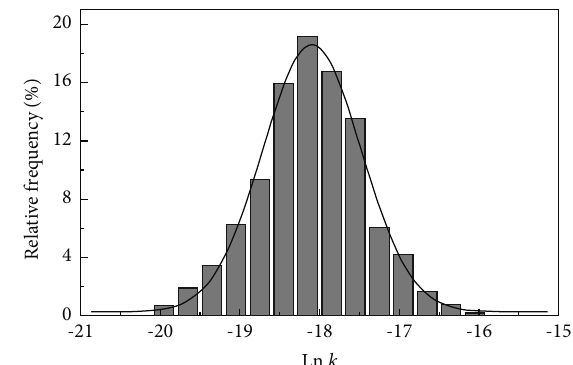
Figure 3: Probability density distribution of the hydraulic con- ductivity in the